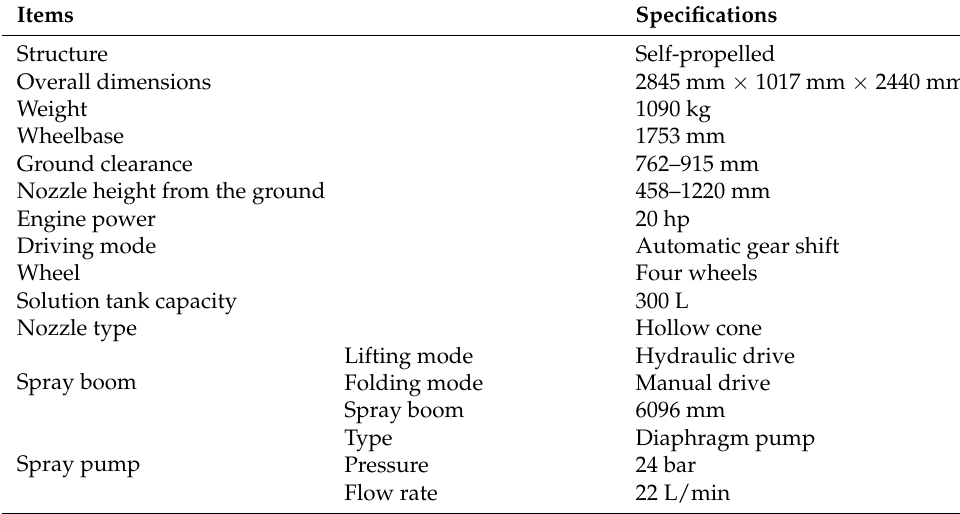
Table 1. Spraying vehicle specifications.